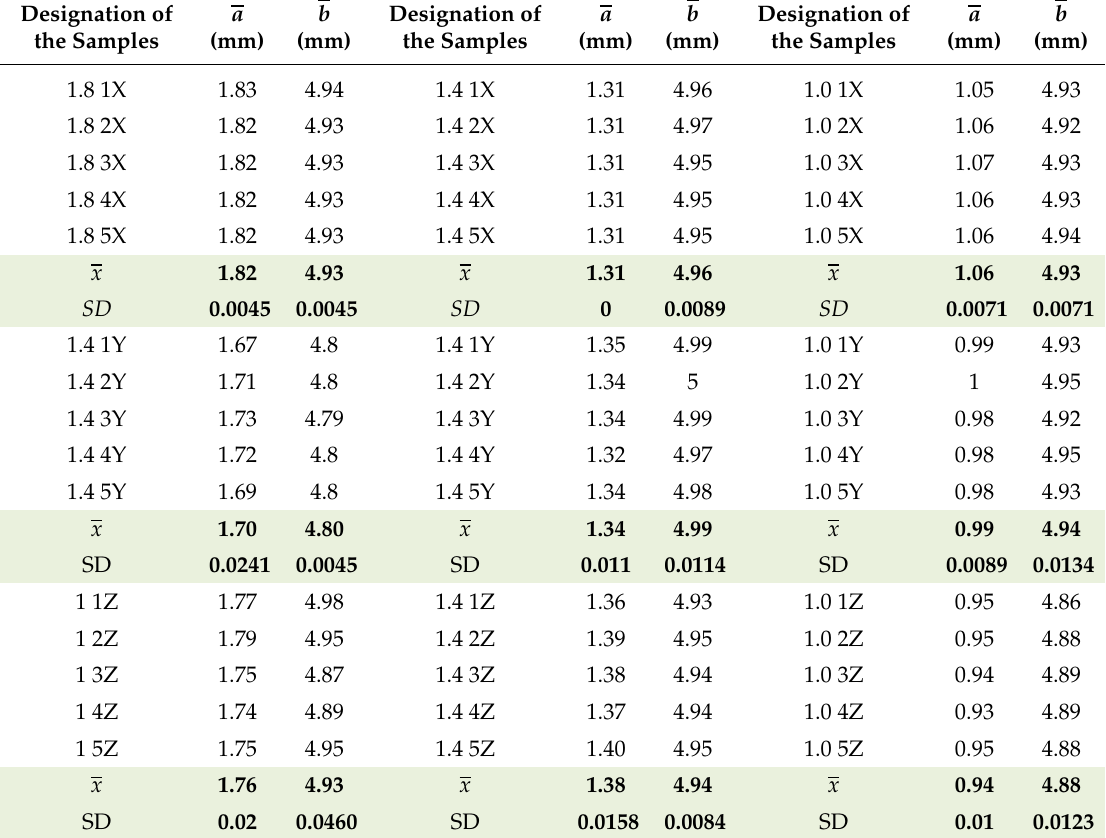
Table 2. Dimensions of the printed samples before tensile strength